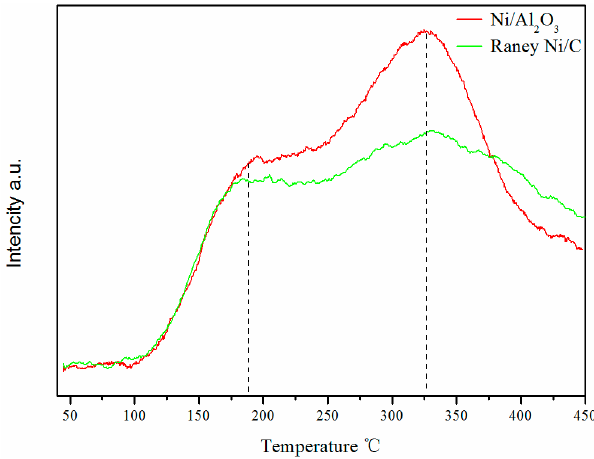
Figure 3. NH 3 -TPD profiles of Raney Ni/C catalyst and Ni/Al 2 O 3 catalyst.